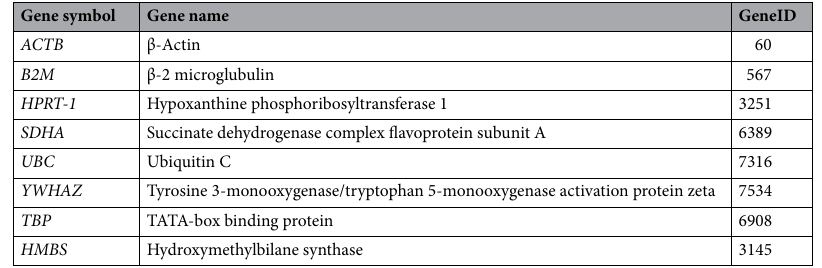
Table 3. List of candidate reference genes.